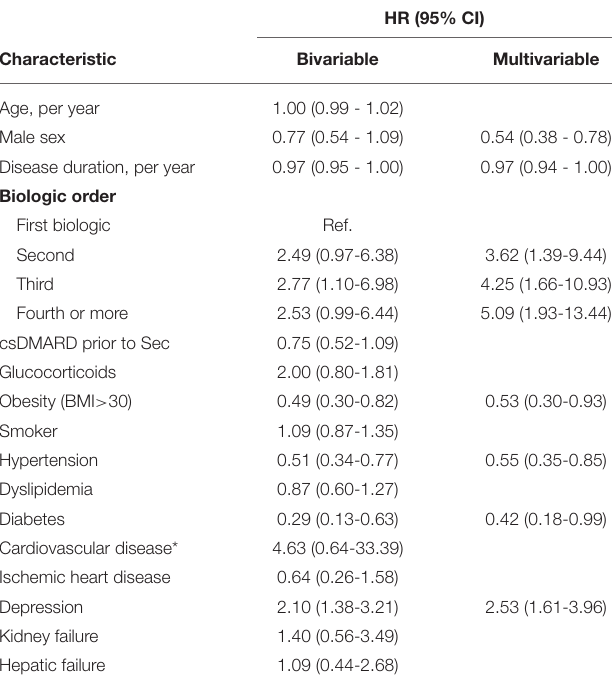
TABLE 3 | Bivariable and multivariable survival